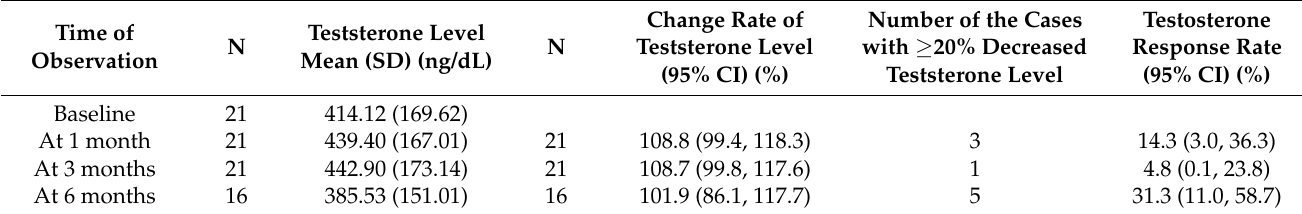
Table 3. The secondary endpoint; testosterone response rate.